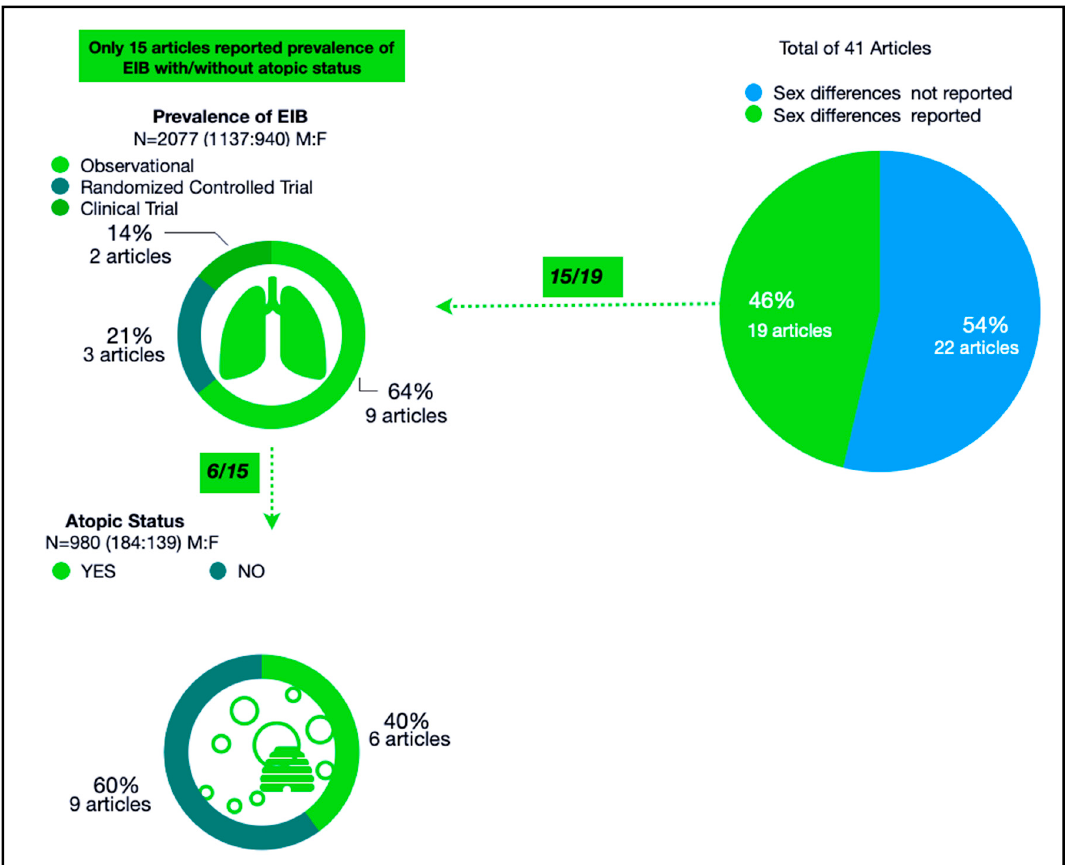
Figure 4. Articles reporting sex differences and atopic status in exercise-induced bronchoconstriction (EIB). Table 3. Sex di ff erences in atopic status.